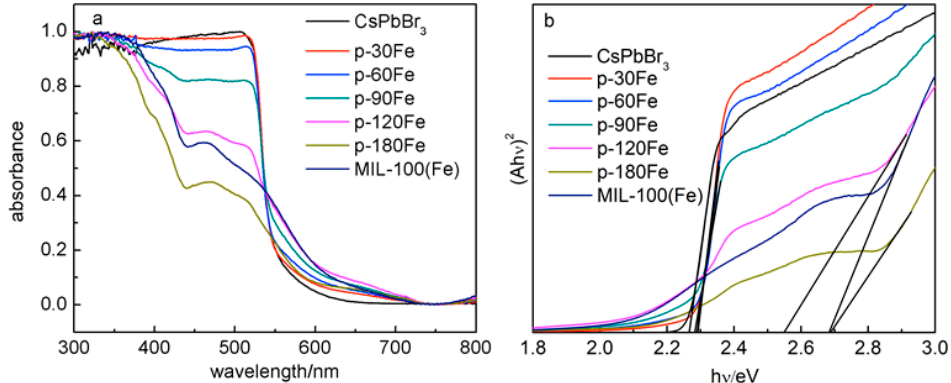
Figure 4. ( a ) UV-vis absorption spectra of parent compounds and composites, and ( b ) Tauc plots of MIL-100(Fe) and the composites. The band gap energies of the photocatalysts, listed in Table 2, were estimated following Kubelka-Munk transformation. Each bandgap is determined by the intersection point of the corresponding tangent line and horizontal axis. Table 2. Bandgap data of the prepared samples.